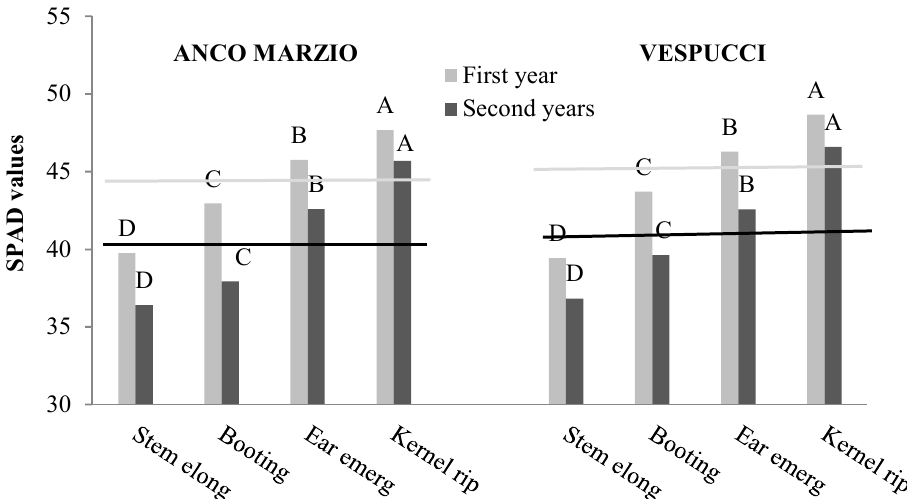
Figure 3. Stripe yellow rust severity in two durum wheat cultivars (Vespucci and Anco Marzio) naturally infected by Puccinia striiformis Westend. f. sp. tritici Erikss. (Pst) under different fertilization regimes during the second year of the crop cycle. Data are means of three replicates (10 leaves for each) where different letters between cultivars indicate different severity to Pst according to the SNK test at the p = 0.01 level. Bar indicates the standard error of the mean (n = 3).